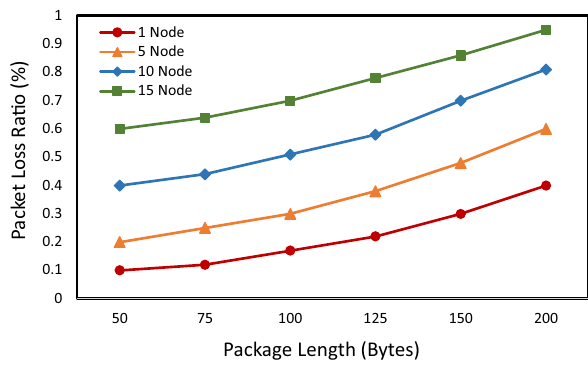
Figure 21. Average packet loss ratio as a function of package length.